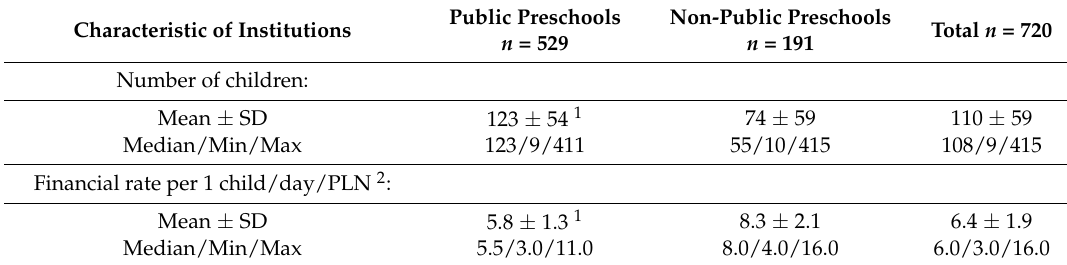
Table 1. General characteristics of preschools: number of children and costs of one day menu per capita. Characteristic of Institutions